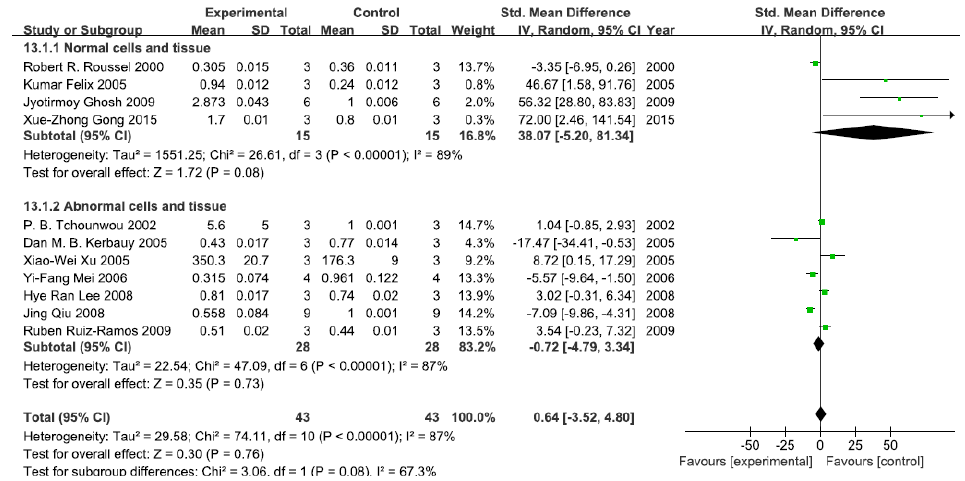
Figure 5. Effects of arsenic on nuclear transcription factor kappa B(NF ‐κ B). Forest plot showing the impact of arsenic treatment on NF ‐κ B compared with controls. Abbreviations: SMD = standardized mean difference, IV = independent variable, 95% CI = 95% confidence interval.